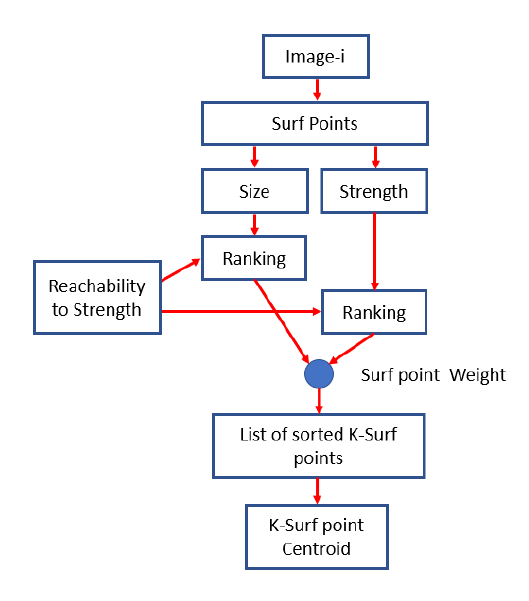
Figure 3. SURF ranking